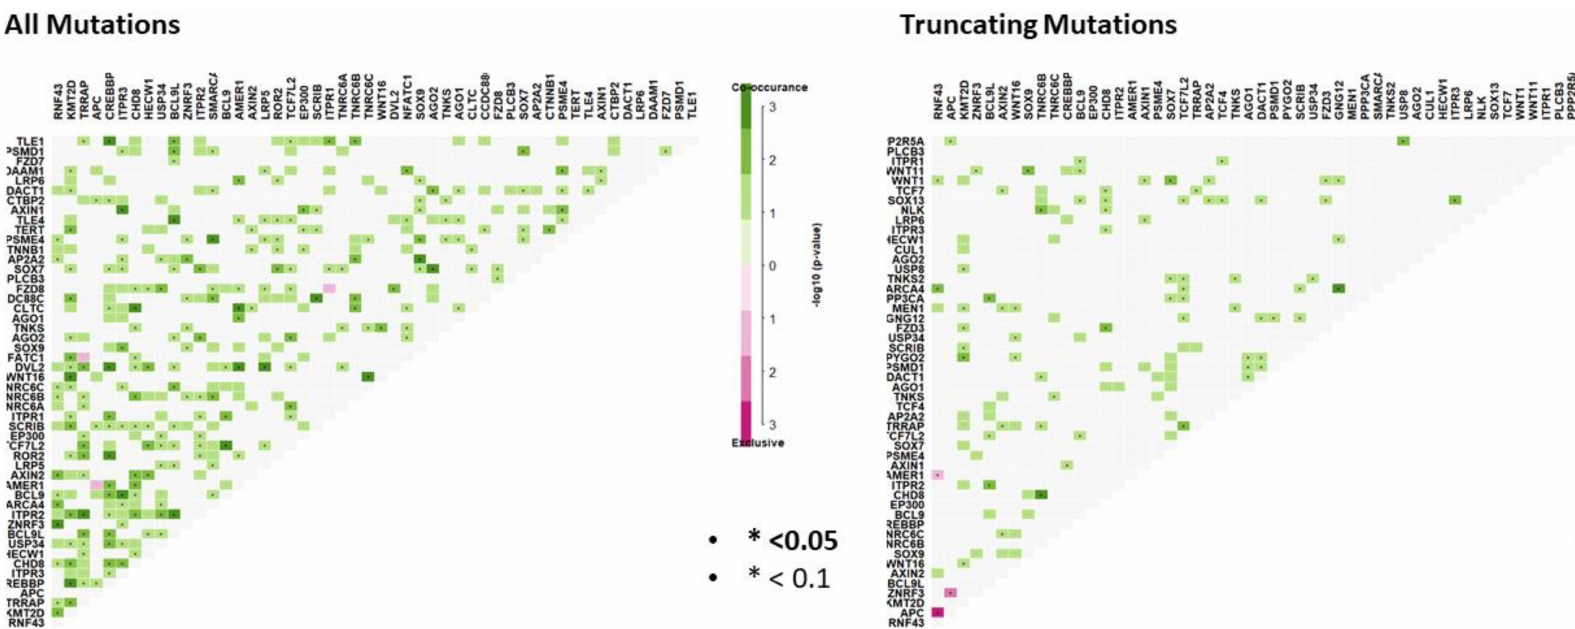
Figure 3. Somatic interaction analysis reveals mutually exclusive mutations between gene pairs, and significant co-occurring mutations. Co-occurring mutations are indicated by green squares and mutually exclusive mutations between gene pairs in purple. The intensity of the color is proportionate the –log10 ( p -value). p -values were determined using Fisher’s exact